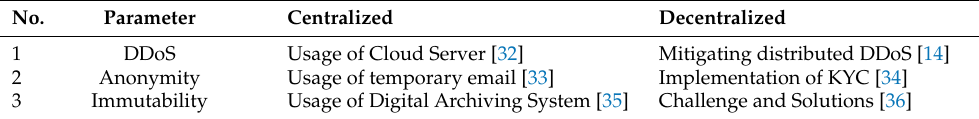
Table 4. Security